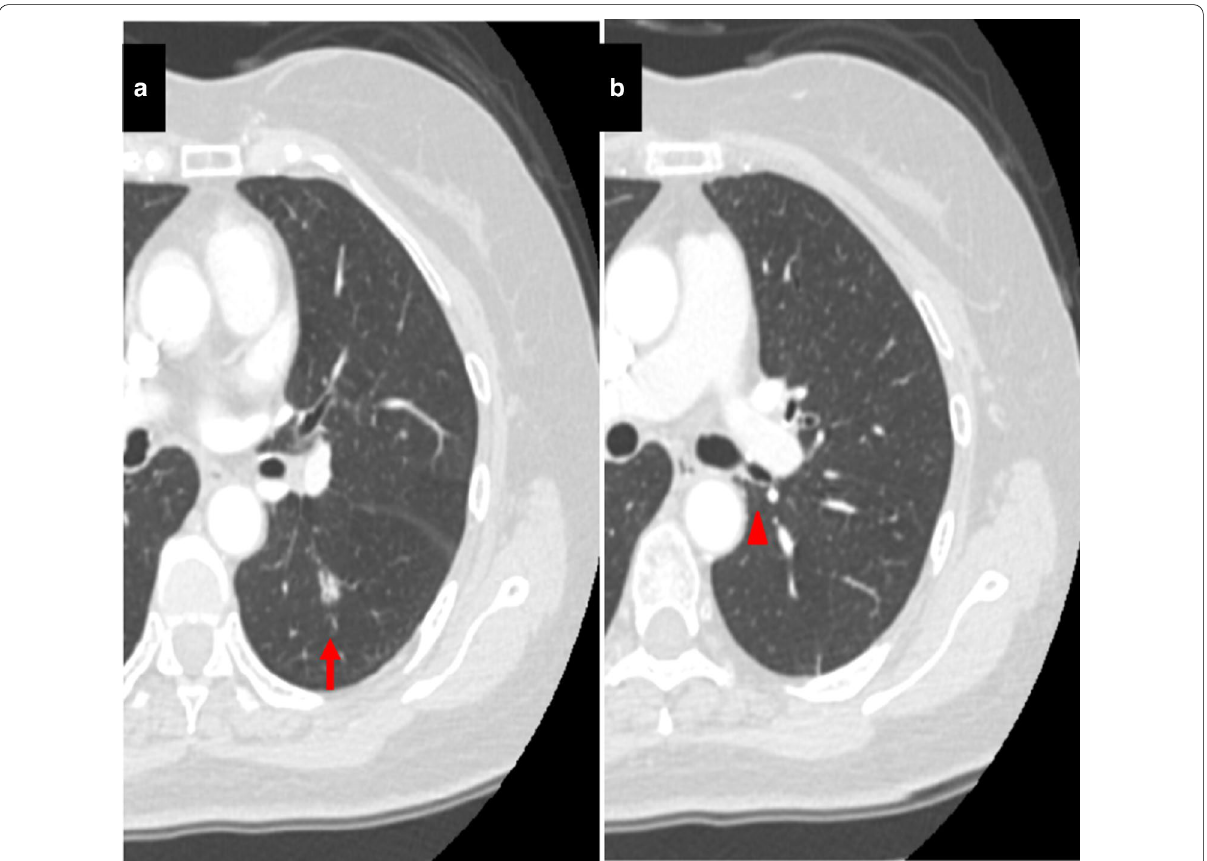
Fig. 1 Chest computed tomography images. Contrast-enhanced CT imaging shows the lung tumor located at the left S6 segment ( a , arrow) and a displaced B 1 + 2 ( b ,